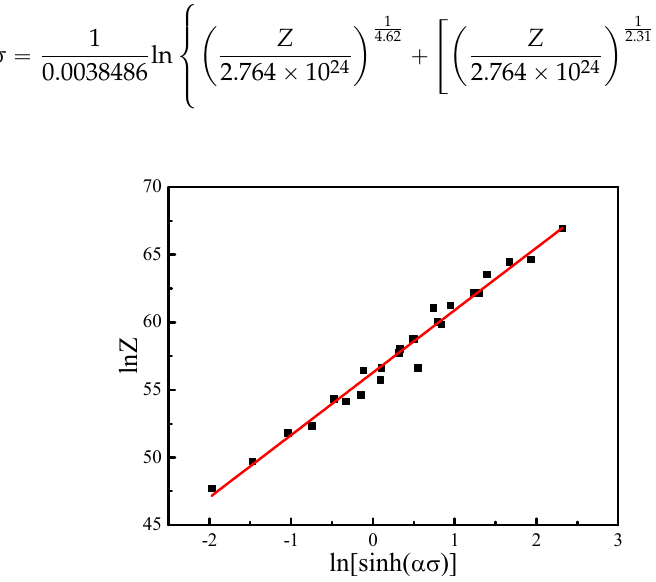
Figure 5. Relationship between ln Z -ln r sinh p ασ qs . Metals 2016 , 6 , 161